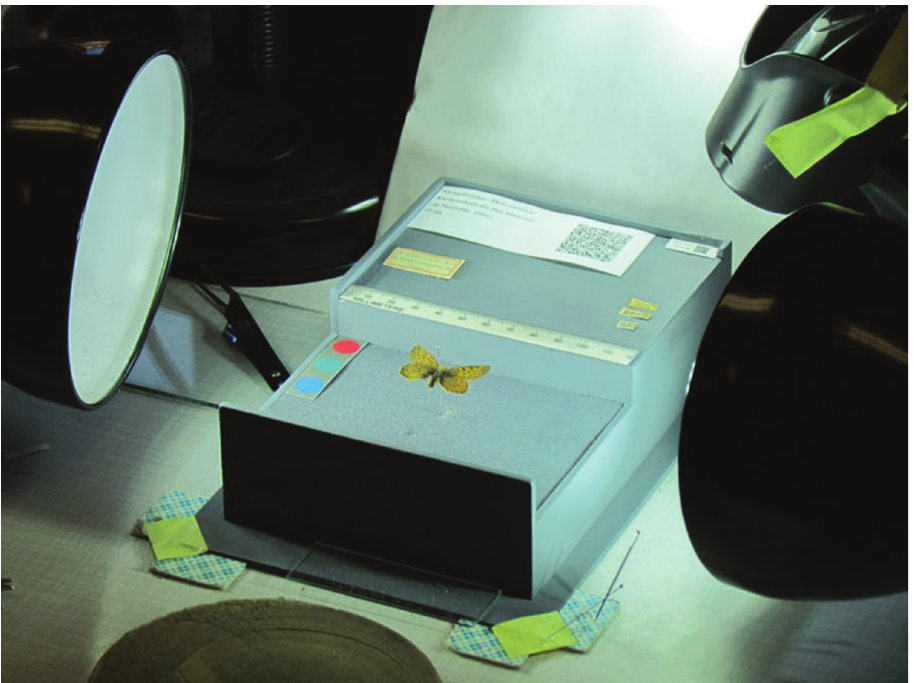
Figure 3. Custom specimen holder. Museum of Compartive Zoology (MCZ) Rhopalocera (Lepidoptera) Rapid Digitization